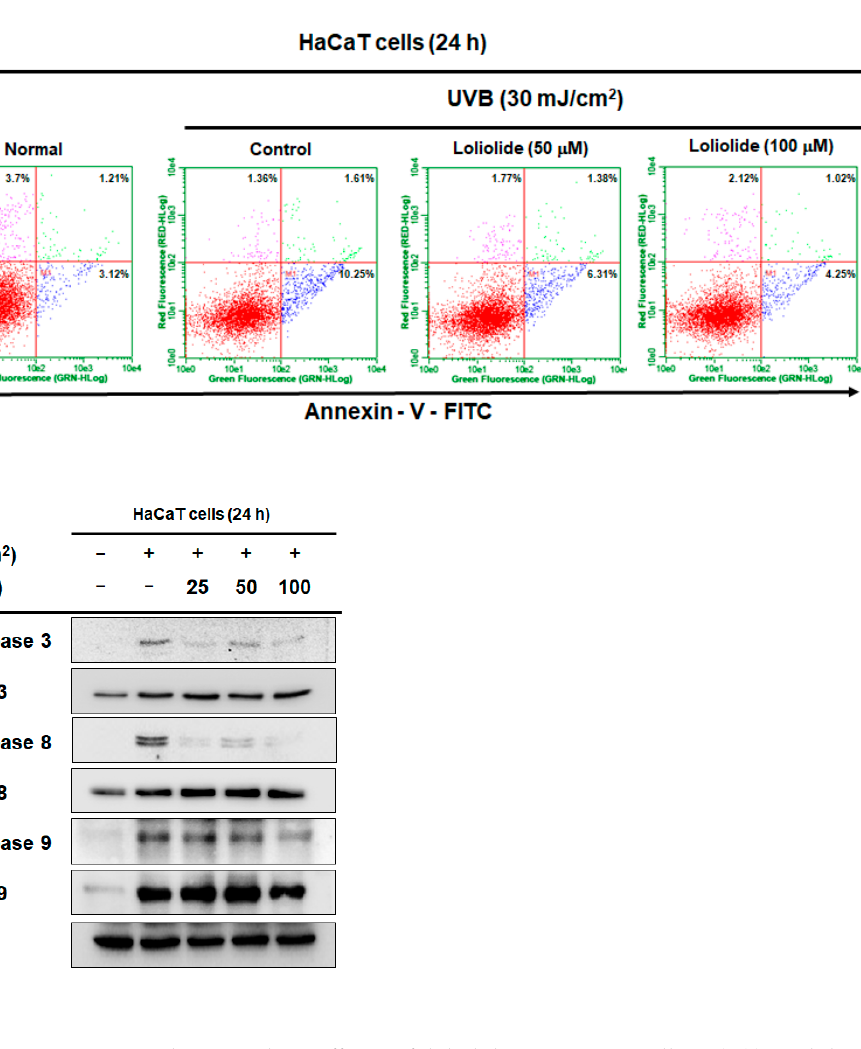
Figure 2. Antiapoptotic and antioxidant effects of loliolide in HaCaT cells. ( a , b ) Viability of HaCaT cells after being treated with loliolide alone or loliolide plus UVB, as measured by 3-(4,5-dimethylthiazole-2-yl)-2,5-diphenyltetrazolium bromide (MTT) assay. ( c ) Reactive oxygen species (ROS) generation in H 2 DCFDA-stained HaCaT cells treated with UVB and loliolide was analyzed by confocal microscopy and quantified by calculation of H2DCF-DA intensity signal using ImageJ. ( d ) DAPI staining in HaCaT cells treated with UVB and loliolide. ( e ) FACS analysis in HaCaT cells treated with UVB and loliolide. ( f ) Western blot analysis of the expression of proteins in the apoptosis signaling pathway in UVB- and/or loliolide-treated HaCaT cells. Statistical signi fi cance was evaluated using the Kruskal–Wallis/Mann–Whitney U test. ## p < 0.05 compared with the normal group (a: Loliolide − or b, c and d: UV − /Loliolide − ) and * p < 0.05 and ** p < 0.01 compared with the control group (b, c, and d: UV+/Loliolide − ).